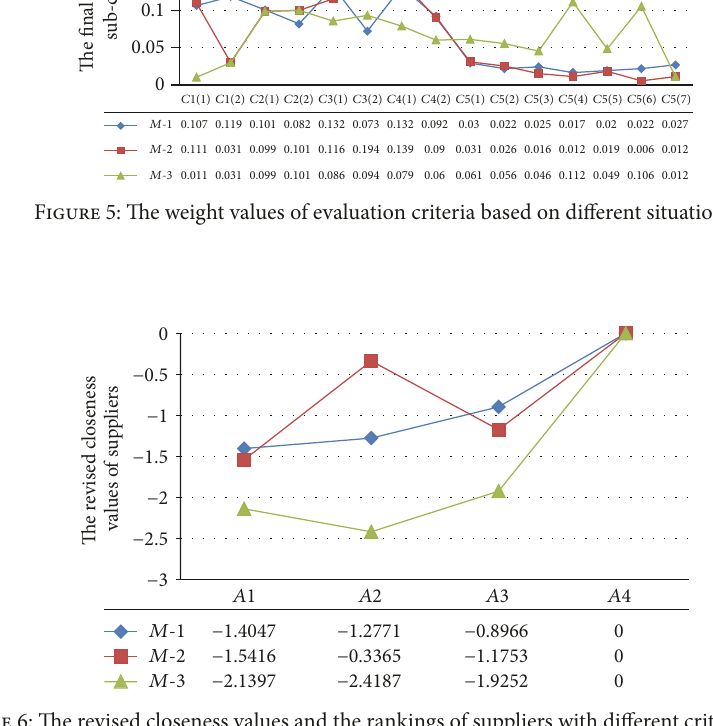
Figure 6: The revised closeness values and the rankings of suppliers with different criteria weights.